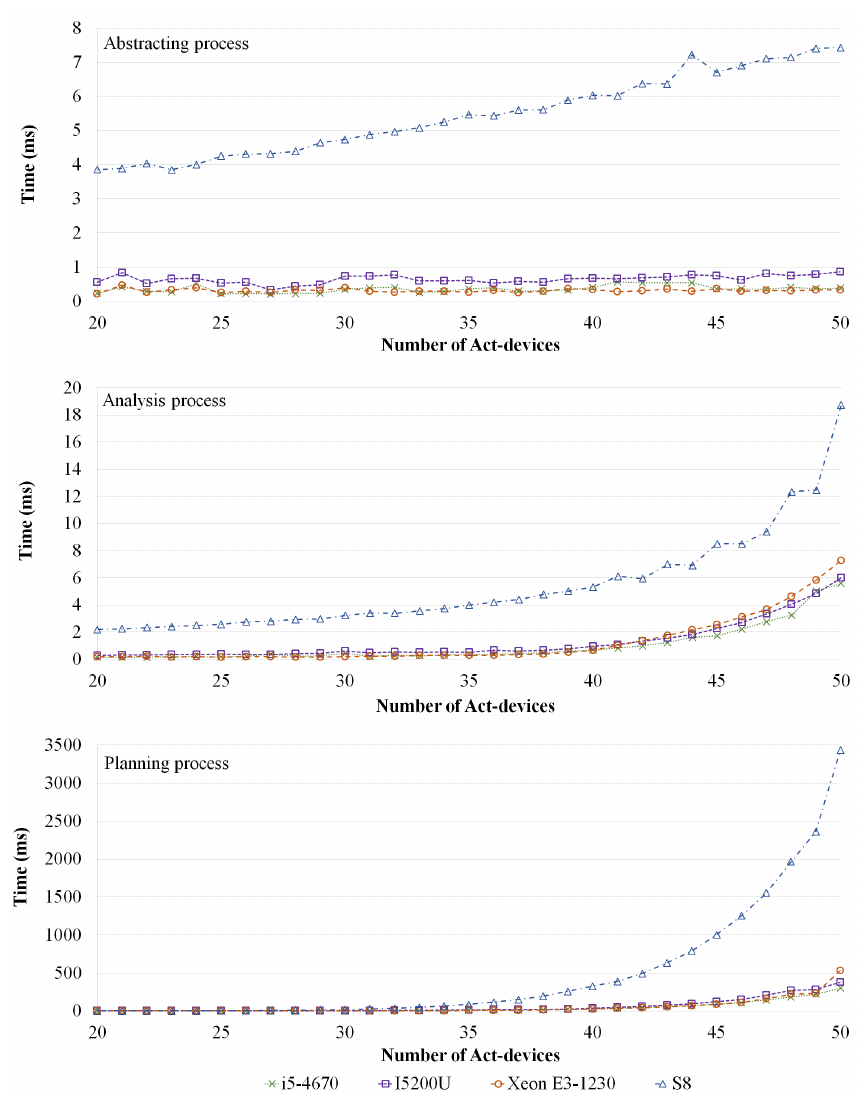
Figure 3. Results with fixed requirements and increasing number of